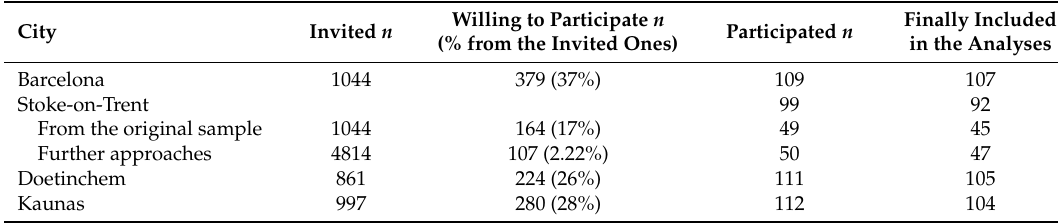
Table A1. Sampling strategy and participation